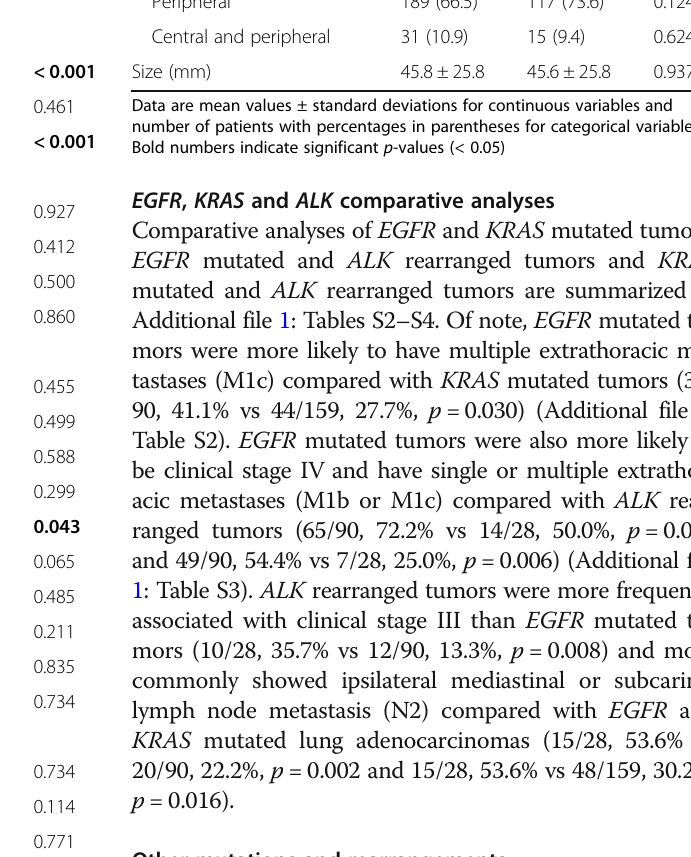
EGFR , KRAS and ALK comparative analyses